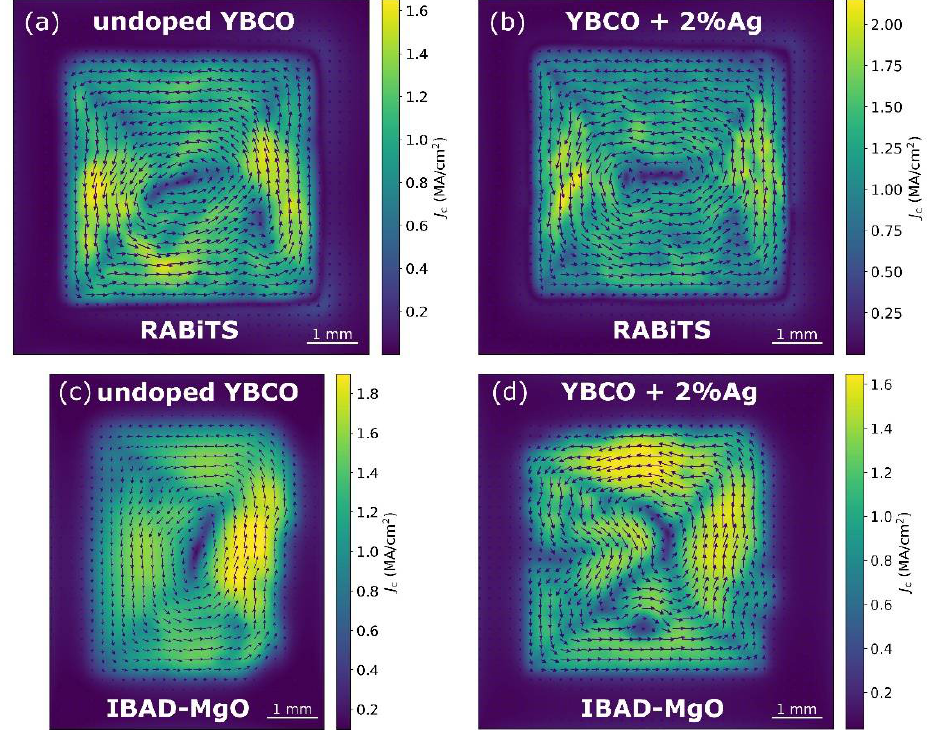
Figure 7. Local critical current density distribution of the undoped and Ag−doped YBCO films calculated from SHPM maps on ( a , b ) RABiTS and ( c , d ) IBAD−MgO. The sample size was 5 mm × 5 mm.